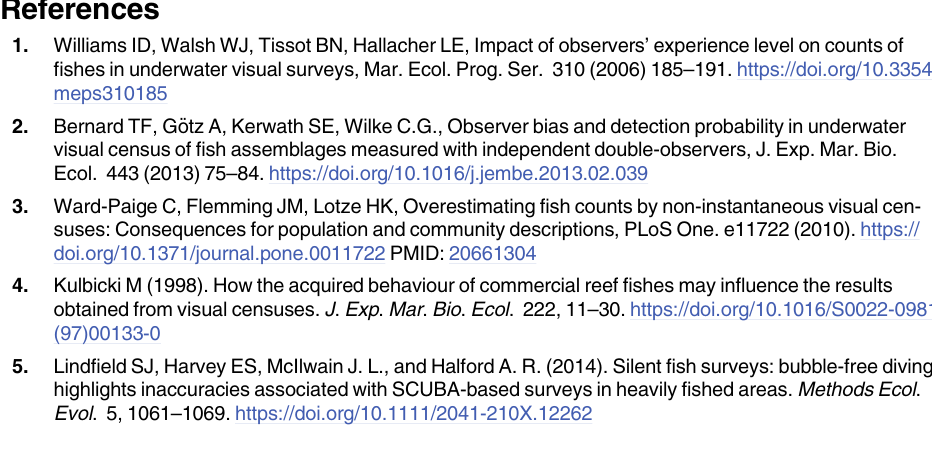
S1 Fig. Abundance and biomass ratio for all species observed in at least 15